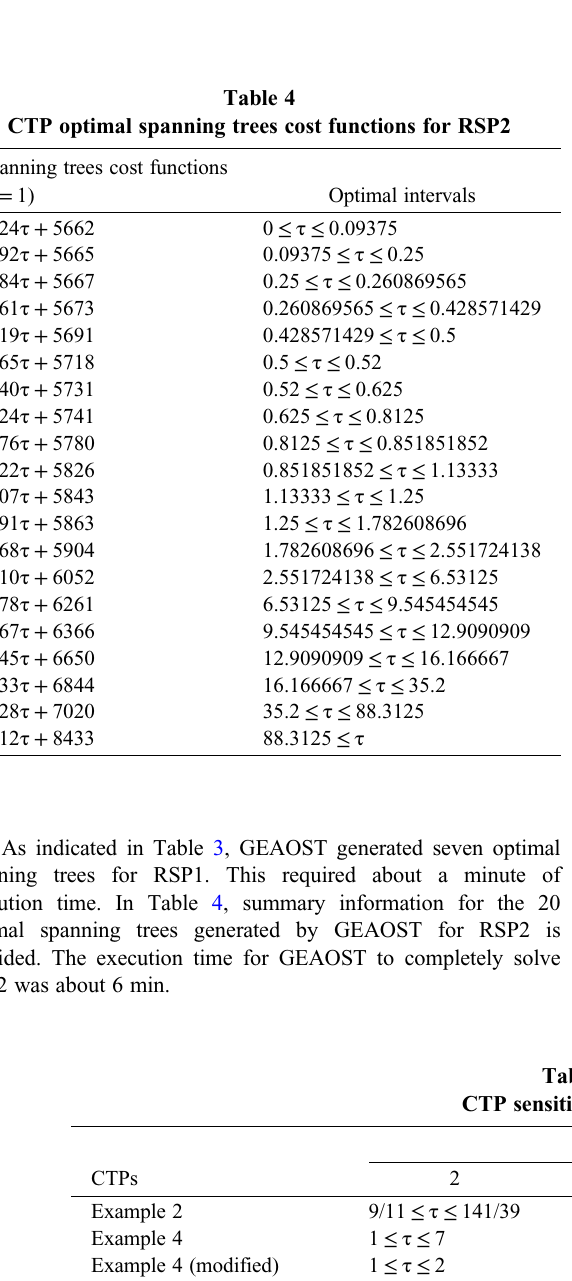
CTP optimal spanning trees cost functions for RSP2 Spanning trees cost functions